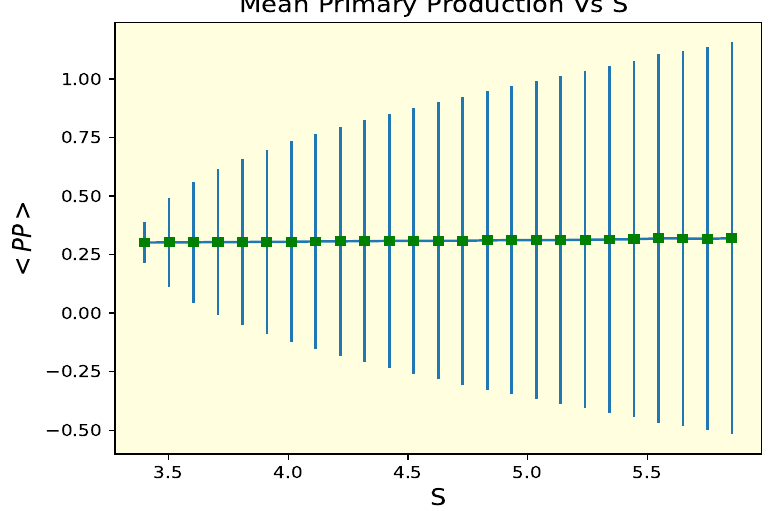
Fig. 7: Average primary production according to the upwelling intensity S .